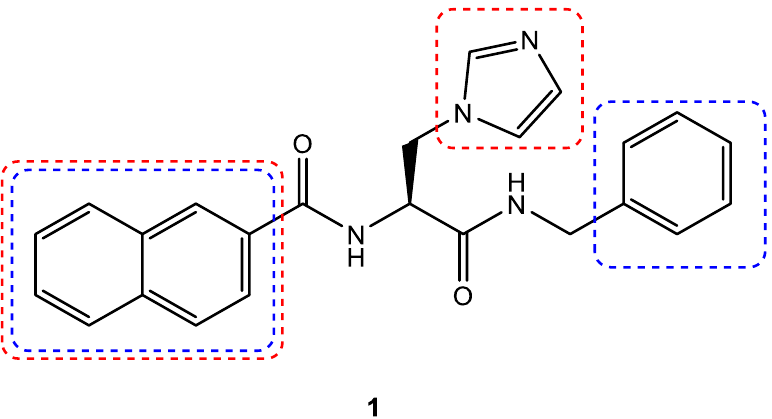
Figure 10. Chemical structure of 1 . Naphthyl, phenyl and imidazole fragments that match with pharmacophore features of the squalene cyclooxygenase model (blue) and CYP51 model (red), respectively, were connected to give 1 with dual-target inhibition [271].